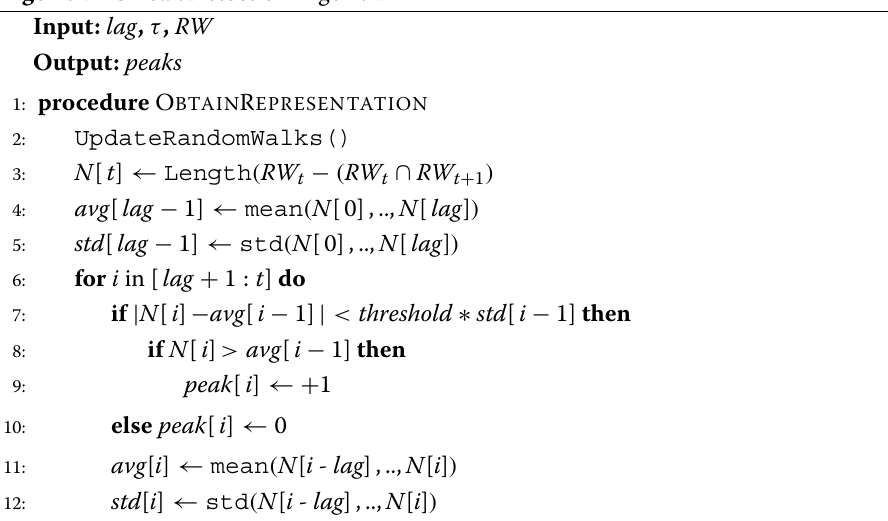
Algorithm 3 Peak Detection